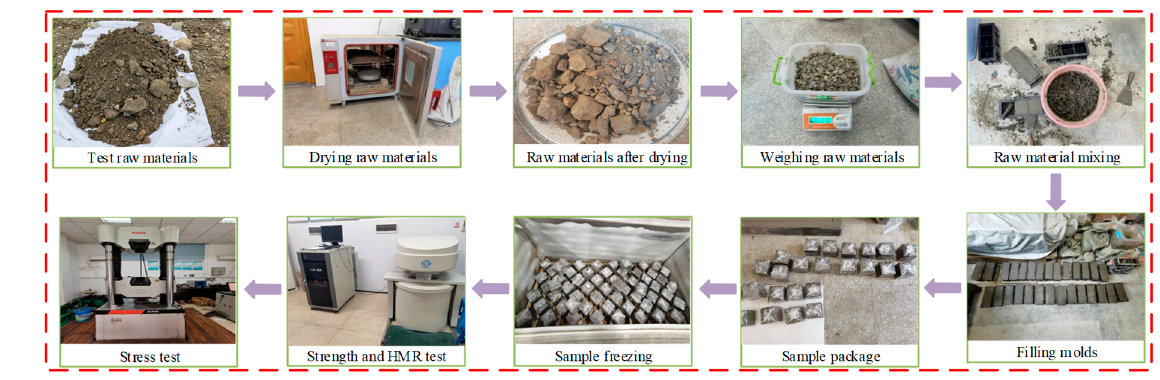
Figure 3. Test flow chart. Table 3. CPMG sequence parameters of coarse-grained soil porosity test.